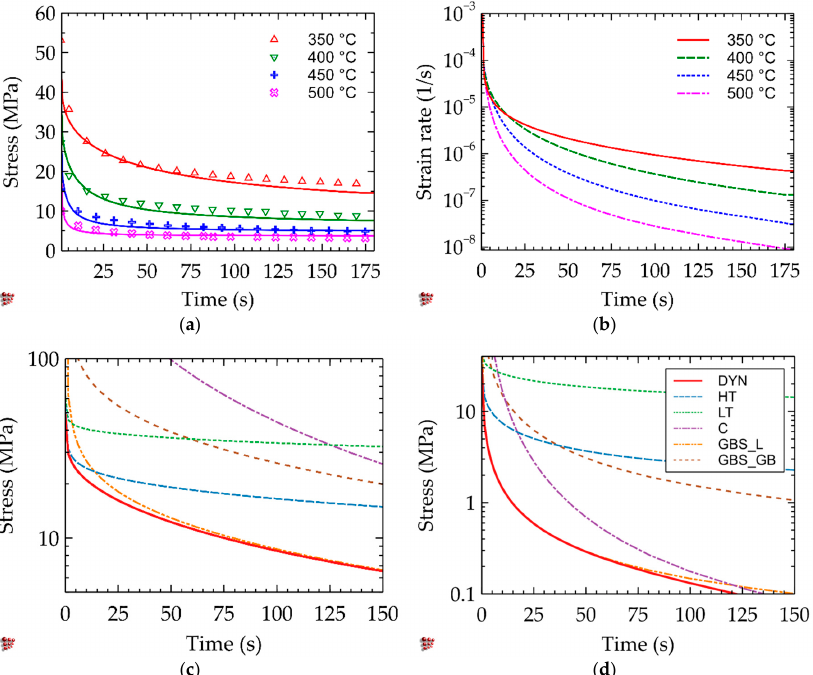
Figure 3 . ( a ) Relaxation tests of an AlMg4.5Mn aluminum alloy at different temperatures. The solid lines are the simulations, whereas the symbols indicate the experimental results from [50]; ( b ) logarithmic strain rate reduction; logarithmic stress calculations of HT creep (HT), LT creep (LT), Coble creep, 𝐷 (cid:2917)(cid:2912) - and 𝐷 (cid:2922) -controlled GBS and the total thermal stress contribution (DYN) ( c ) at 350 °C and ( d ) at 500